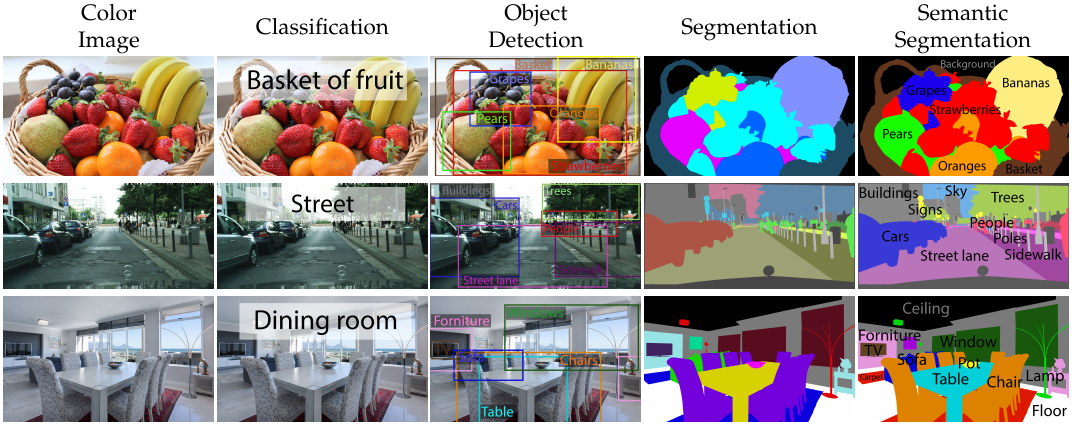
Figure 1. Overview of some possible visual tasks on a few sample images from classification (sparse task) to semantic segmentation (dense